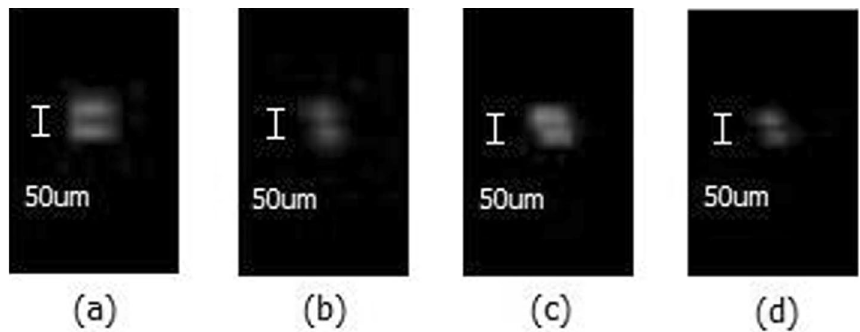
Figure 5. The results of resolution test imaging: ( a ) Single-pulse transmission. ( b ) 4-bit Golay-coded transmission. ( c ) 8-bit Golay-coded transmission. ( d ) 16-bit Golay-coded